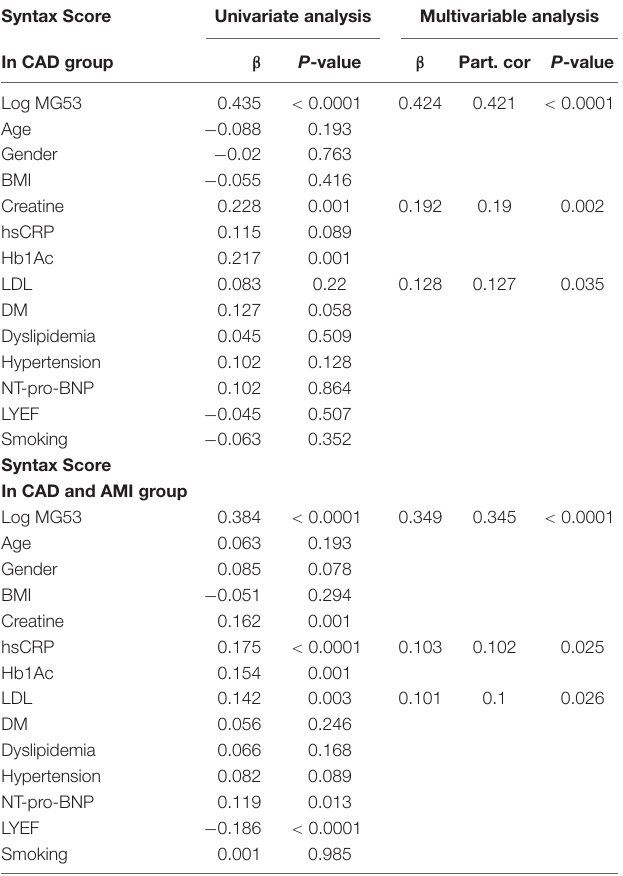
TABLE 4 | Linear regression models for SYNTAX score in different groups.